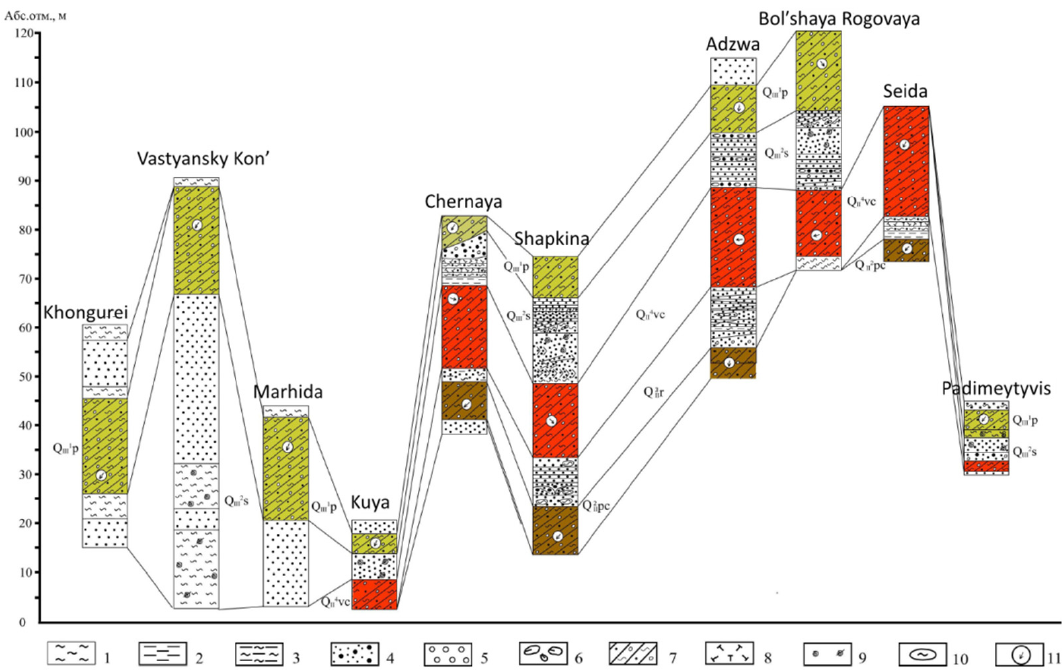
Figure 4. Correlation of Neopleistocene deposits in the north of the Bolshezemelskaya tundra reproduced with permission from [39]. 1: clay; 2: aleurite; 3: clayey silt; 4: sand with gravel; 5: pebbles; 6: boulders; 7: moraine; 8: peat; 9: shells and shell fragments of mollusks, foraminifera; 10: clay pellets; 11: orientation of elongated rock fragments in the moraine.